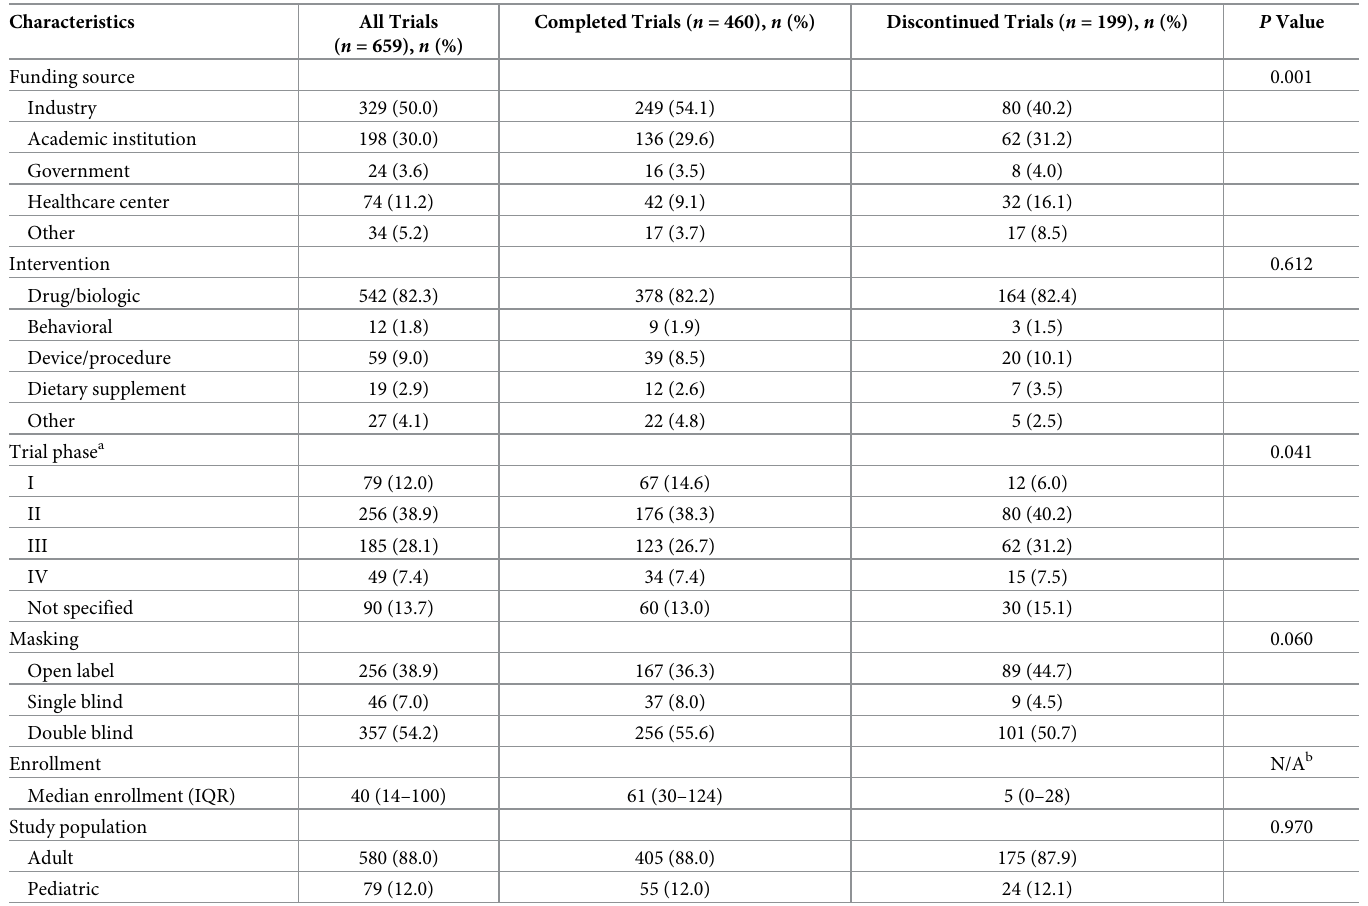
Table 2. Characteristics of completed and discontinued trials for rare diseases.